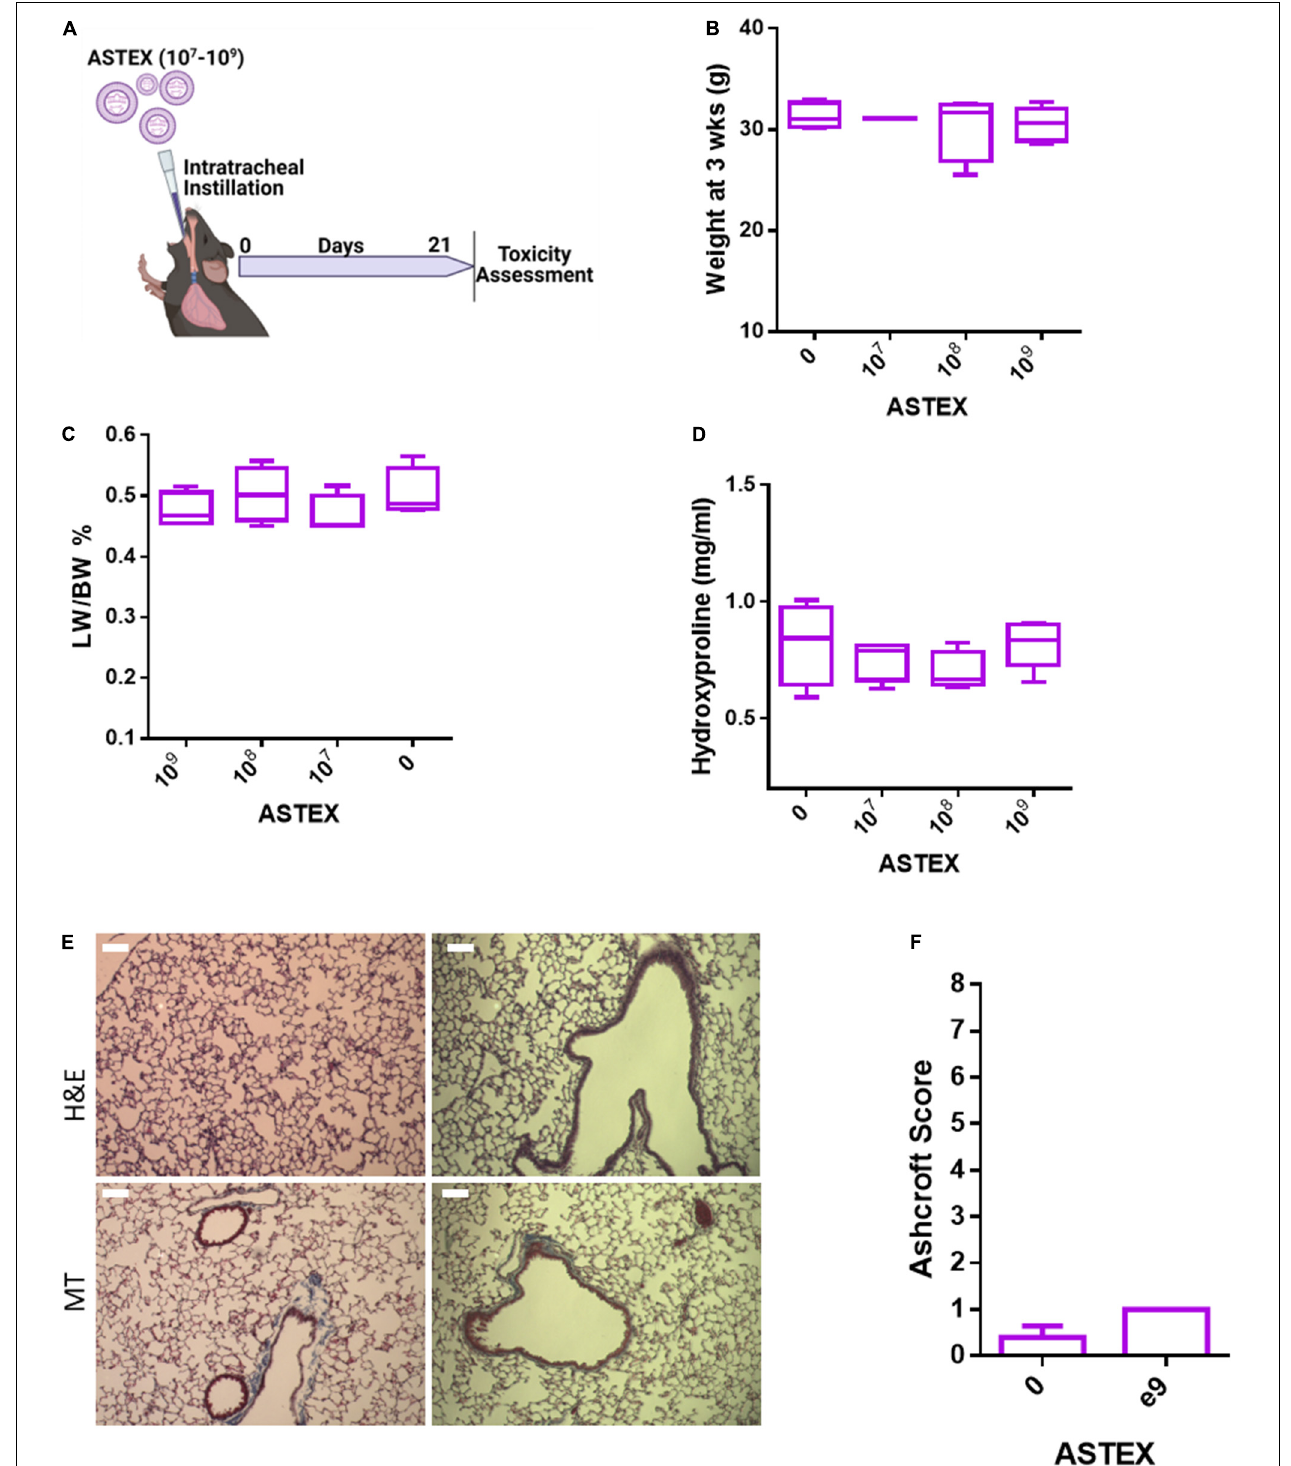
FIGURE 5 | ASTEX have a favorable safety profile in healthy mice. (A) Design of safety study. (B) Animal weight at 3 weeks postintratracheal instillation of different doses of ASTEX. (C) Lung weight to body weight ratio of animals at 3 weeks postexposure. (D) Lung fibrotic content as measured by hydroxyproline context in tissue 3 weeks postexposure. (E) H&E staining and Masson’s trichrome of lung tissue and (F) tissue scoring ( n = 4–5 animals per group) Statistical analysis was done using one way ANOVA with Tukey’s multiple comparisons test. * p < 0.05, ** p < 0.01, *** p < 0.001.